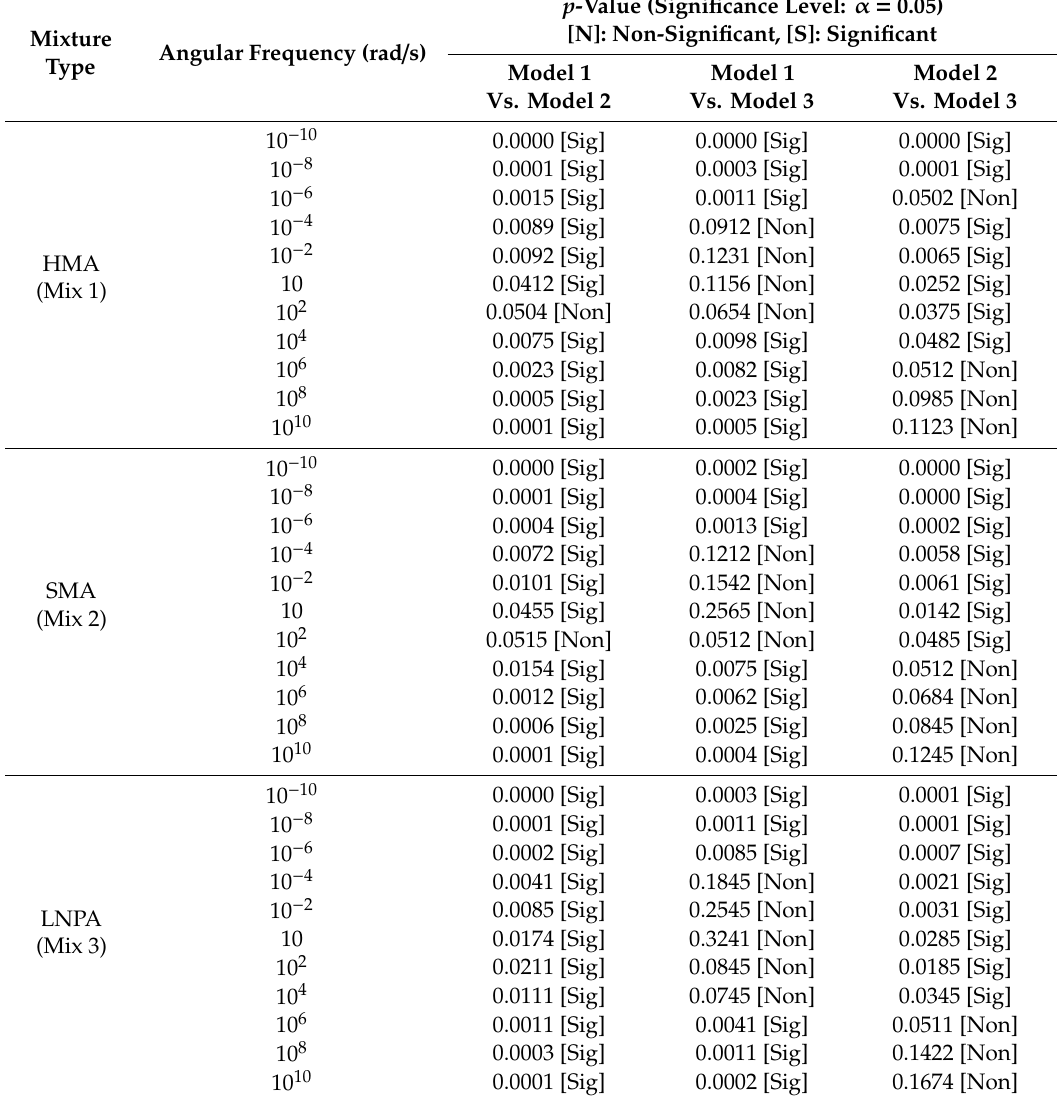
Table 3. Results of t -test for | E *( ω ) |